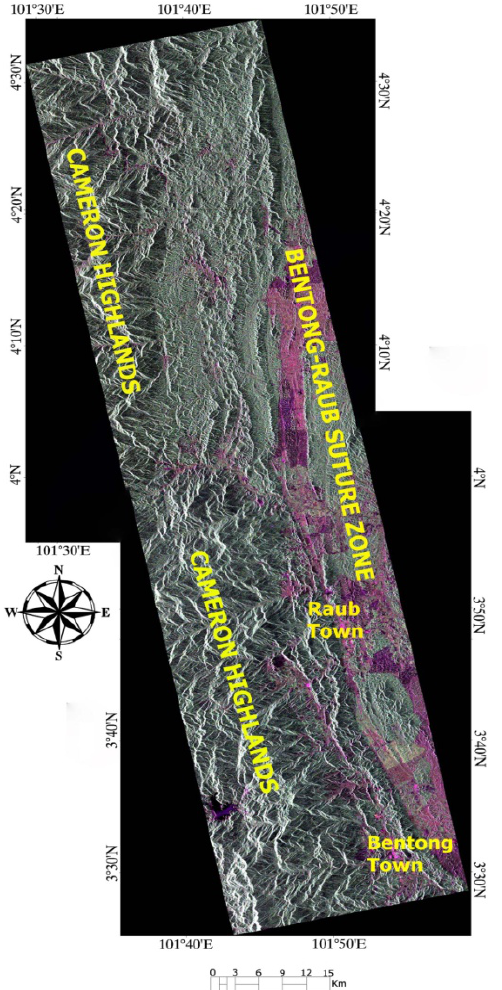
Fig. 2. RGB color combination of PALSAR polarimetric HH, HV and VV images, southeastern part of the Bentong-Raub Suture Zone.